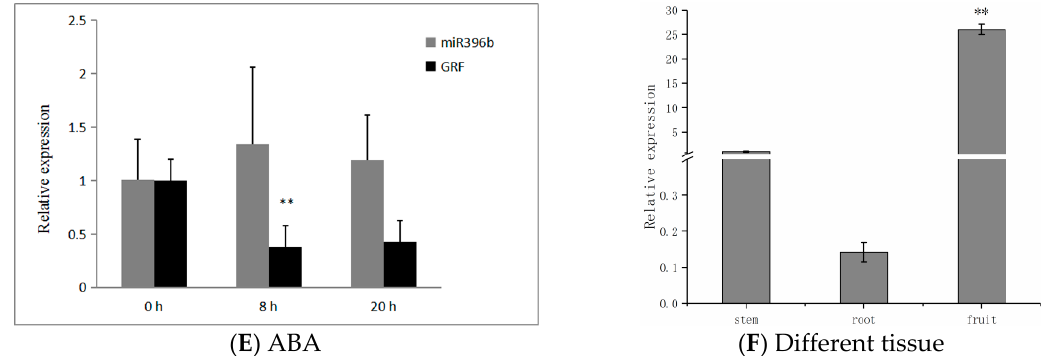
Figure 8. Expression patterns of hpo-miR396b and the target gene HpGRF6 under exposure to different treatments: ( A – E ) expression of hpo-miR396b and HpGRF6 induced by polyethylene glycol (15% PEG-8000), 42 ± 1 °C , 4 ± 1 °C , NaCl (100 mM) and abscisic acid (ABA; 0.38 mM); ( F ) expression of hpo-miR396b in different tissues. All data were analyzed by two-way ANOVA, and followed by Duncan’s multiple range test. “*” indicates a significant difference at the level of p < 0.05. “**” indicates a significant difference at the level of p < 0.01.